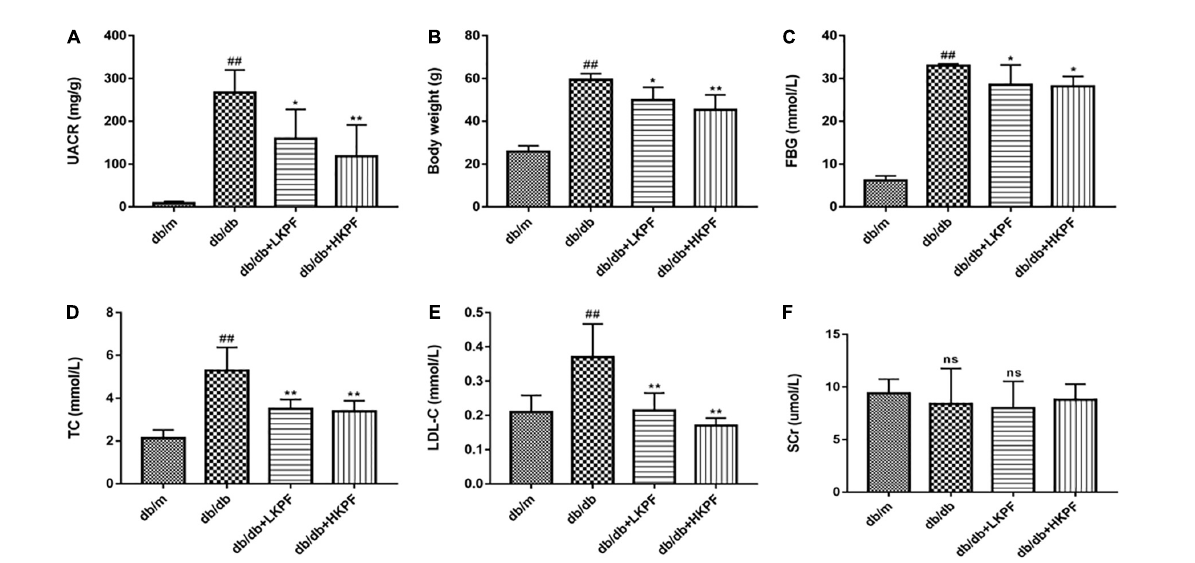
FIGURE1 Kaempferol alleviated dysregulated UACR, BW, FBG and dyslipidemia levels of db/db mice. (A) Urine albumin-creatine ratio (UACR) (mg/g), (B) Body weight (g), (C) Fasting blood glucose (FBG) (mmol/L), (D) Total cholesterol (TC) (mmol/L), (E) Low density lipoprotein-cholesterol